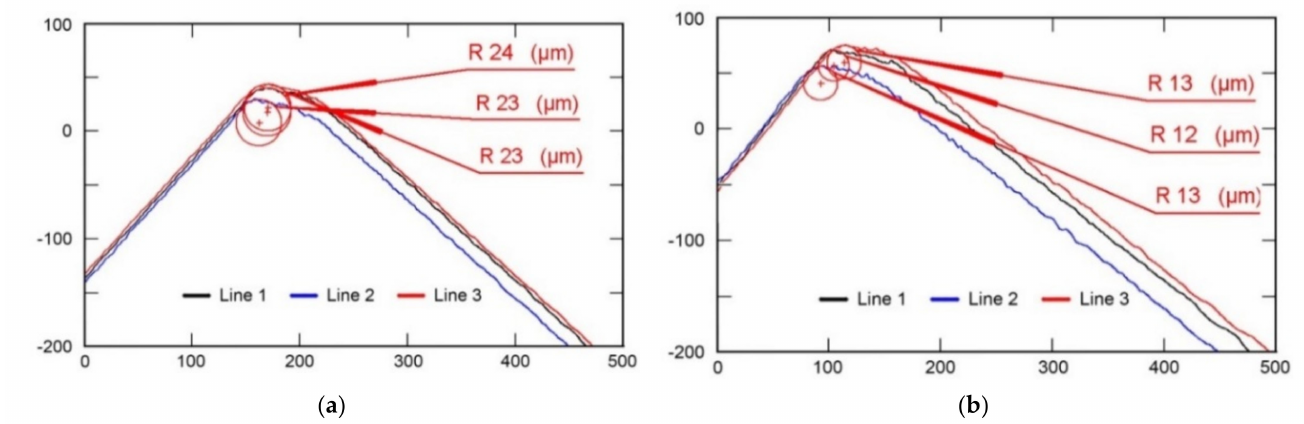
Figure 13. Profiles of cutting wedge in three sections distanced from each other at 0.3 mm with measured radii R of the cutting edge for ( a ) a cutting plate with 3 µ m-thick TiAlN coating; ( b ) cutting plate with 3 µ m-thick TiAlN coating deposited after removal of a 10 µ m-thick defective surface